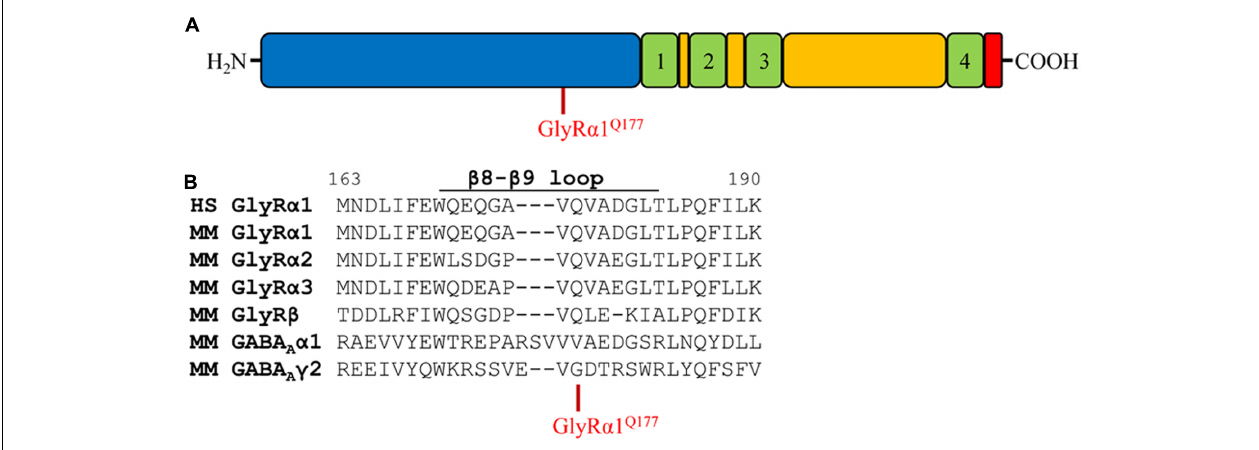
FIGURE 1 | The glycine receptor β 8– β 9 loop. (A) Schematic view of the GlyR domain structure containing the N-terminus (blue), transmembrane domains 1–4 (green) connected by loops (yellow), and C-terminus (red). Residue GlyR α 1 Q177 highlighted in red. (B) Sequence alignment of the β 8– β 9 loop and adjacent residues of human (HS) GlyR α 1, mouse (MM) GlyR α 1, α 2, α 3, β and mouse GABA A α 1, γ 2